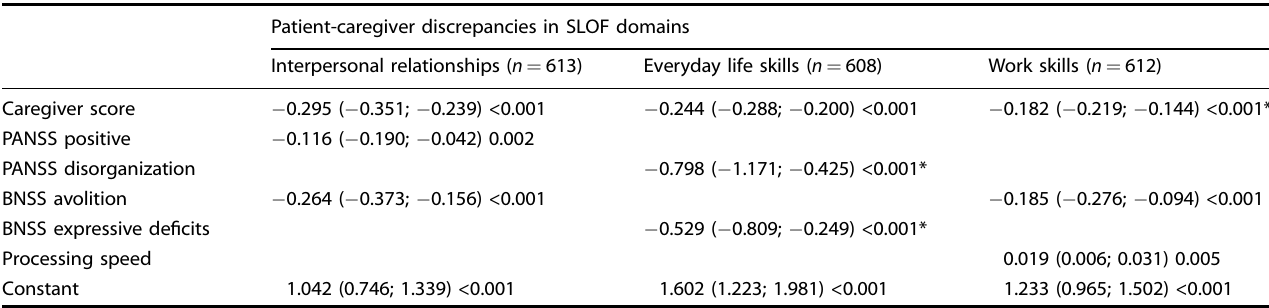
Table 4. Multivariable regressions of patient-caregiver discrepancies in SLOF domains. Patient-caregiver discrepancies in SLOF